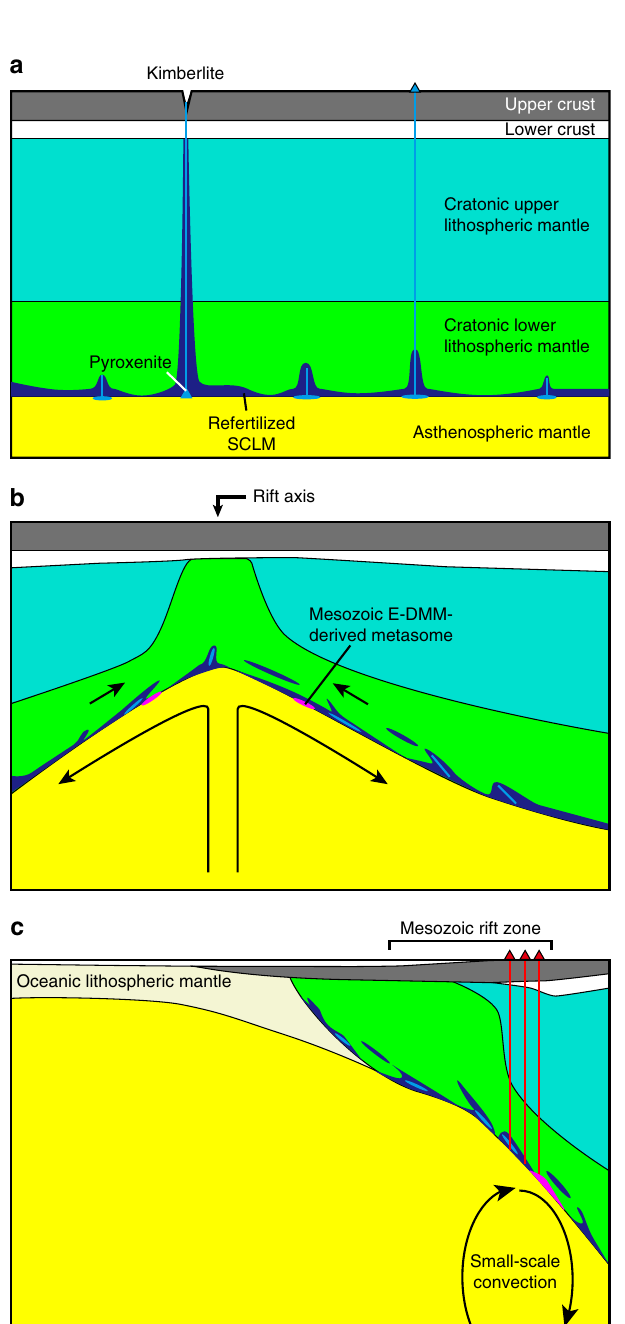
Fig. 5 Schematic cross-sections illustrating the source materials and the associated melting process of Cameroon volcanic line magmas. a Craton before the continental breakup. Image of the subcontinental lithospheric mantle (SCLM) after ref. 69 , which demonstrates how the lowermost region of the cratonic lower lithospheric mantle could have refertilized (refertilized SCLM, shown in blue). b During the initial stage of Mesozoic, continental breakup based on the depth-dependent extension model after ref. 45 . The low-degree partial melt formed by the upwelling asthenospheric mantle at the rift axis could have metasomatized the lower part of the lithospheric mantle (Mesozoic enriched part of the depleted mid-ocean ridge basalt source mantle-derived melt, shown in magenta). c Present. Several tens of million years after the initial rifting, the small-scale convection (SSC) could be developed beneath the step of SCLM 4,57 . The SSC may transform heat to the base of the SCLM, facilitating melting of refertilized SCLM.